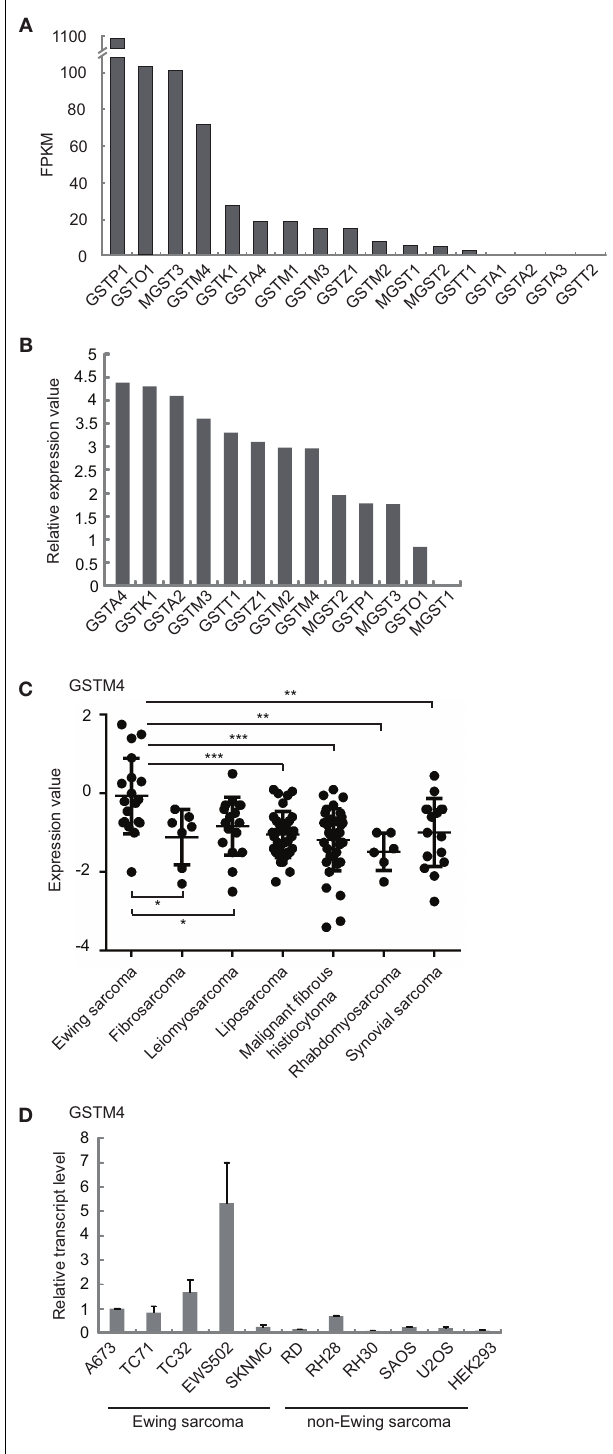
FIGURE 1 | GSTM4 is a major GST specifically expressed in Ewing sarcoma . (A) Expression levels of all detectable GSTs in A673 cells.Total RNA extracted from A673 cells was subjected to cDNA library construction and labeling, followed by next generation sequencing using Illumina HiSeq1000, as described previously (17). GST genes are ranked by value of